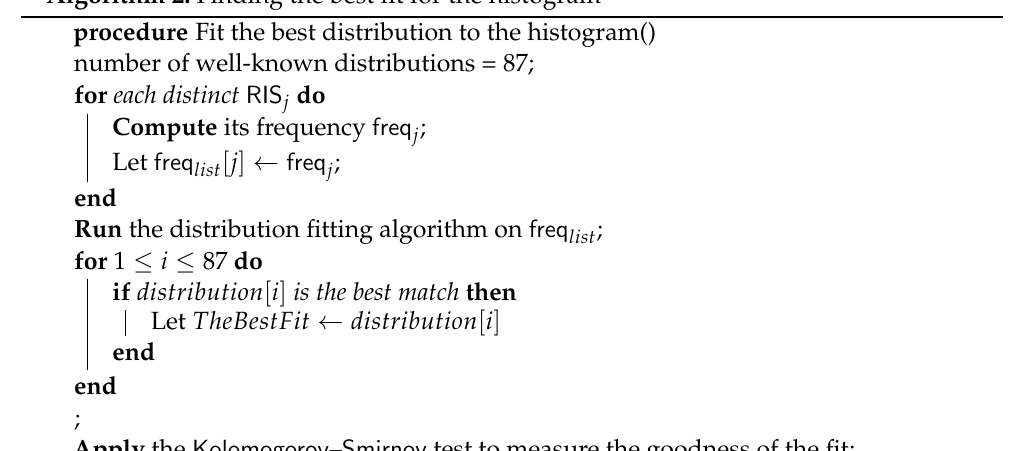
Algorithm 2: Finding the best fit for the